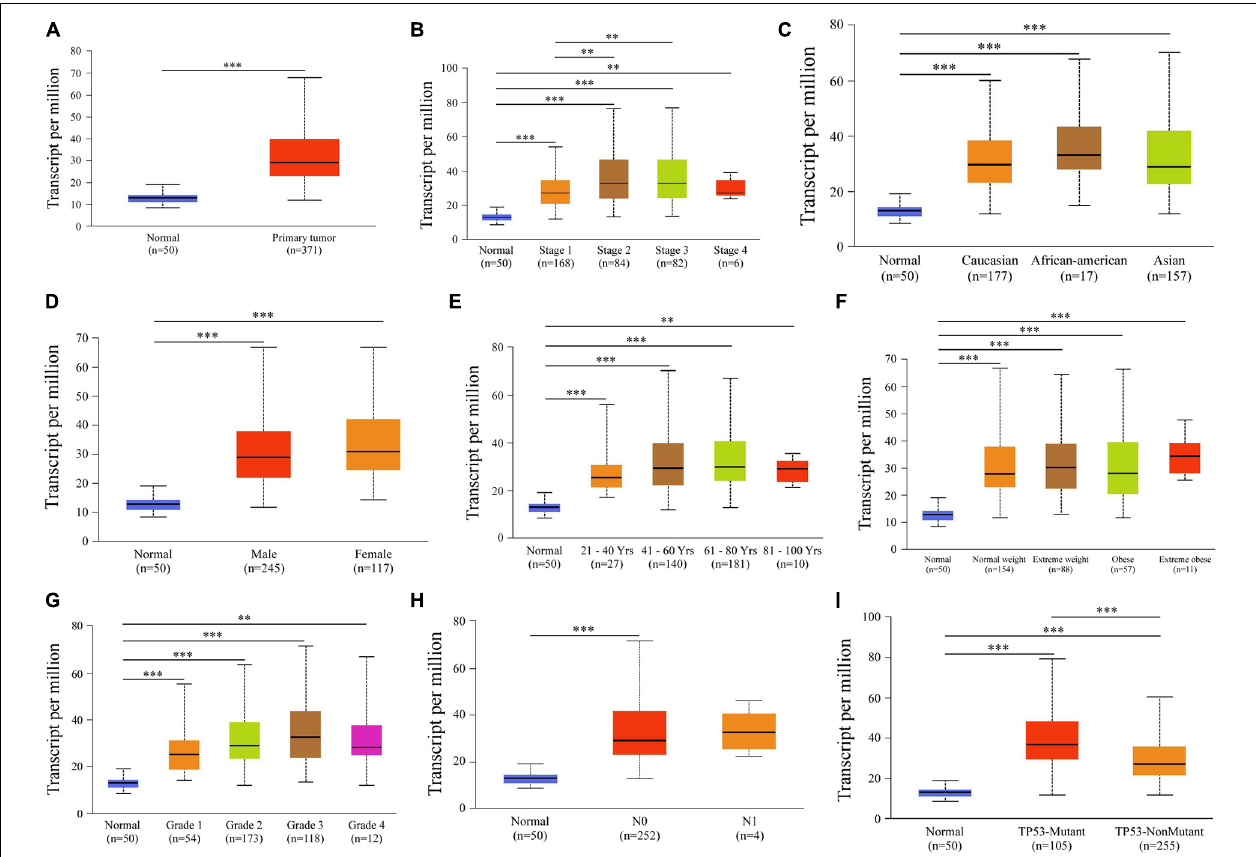
FIGURE 2 | Analysis of subgroup expression of PDZD11 in LIHC (UALCAN database). (A) PDZD11 mRNA expression in LIHC tissue and adjacent normal liver tissue. (B–I ) Box plot shows the PDZD11 mRNA expression of LIHC patients in the subgroups of different cancer stages (B) , race (C) , gender (D) , age (E) , weight (F) , tumor grade (G) , nodal metastasis status (H), and TP53 mutation status (I) . The data are shown as mean ± SE. ∗ p < 0.05; ∗∗ p < 0.01; ∗∗∗ p < 0.001. The asterisk indicates a significant difference between the two sets of